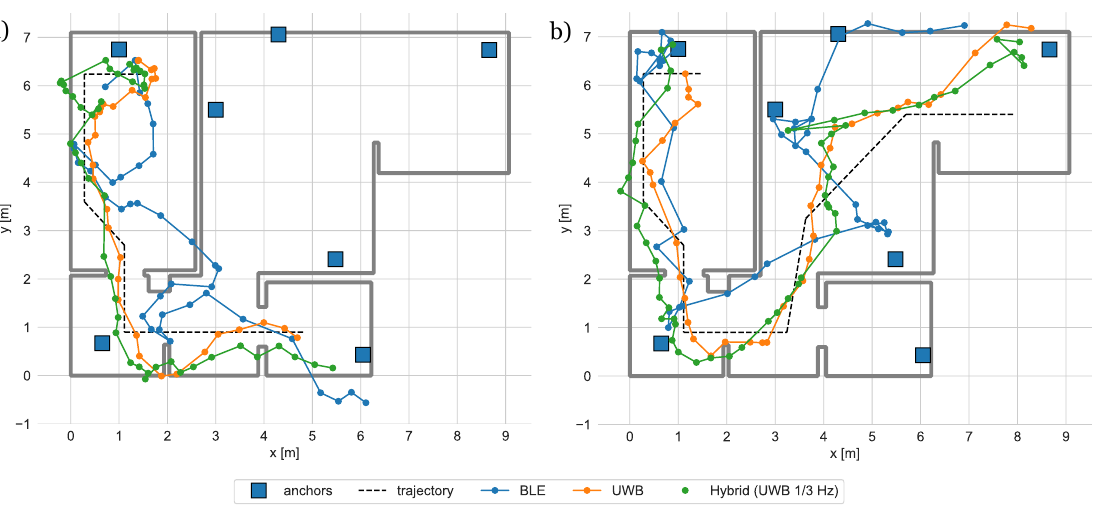
Figure 12. Localization of a moving person results.